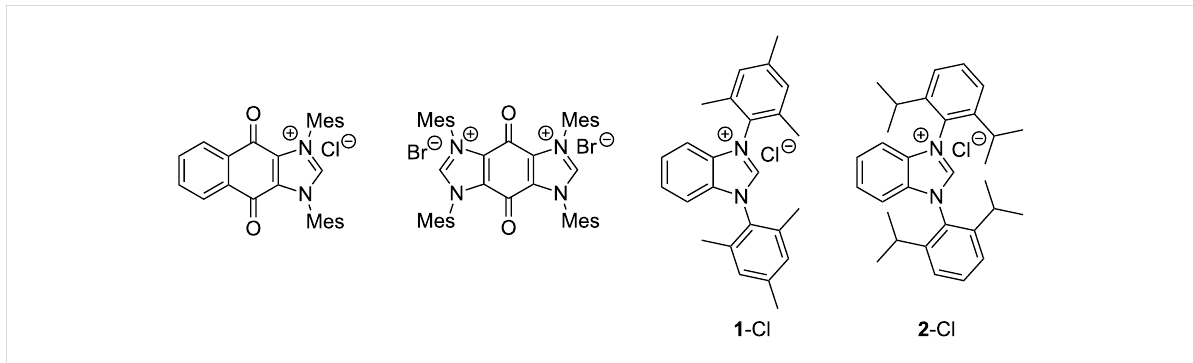
Figure 1: Sterically demanding benzannulated NHCs bearing mesityl rings. From the left side:, 4,9-dihydro-4,9-dioxo-1,3-bis(2,4,6-trimethylphenyl)- 1 H -naphth[2,3- d ]imidazolium chloride [39], 3,4,5,8-tetrahydro-4,8-dioxo-1,3,5,7-tetrakis(2,4,6-trimethylphenyl)-benzo[1,2- d :4,5- d' ]diimidazolium bro- mide [41], 1,3-bis(2,4,6-trimethylphenyl)-1 H -benzo[ d ]imidazol-3-ium chloride ( 1 -Cl) [42,43] and 1,3-bis(2,6-diisopropylphenyl)-1 H -benzo[ d ]imidazol-3- ium chloride ( 2